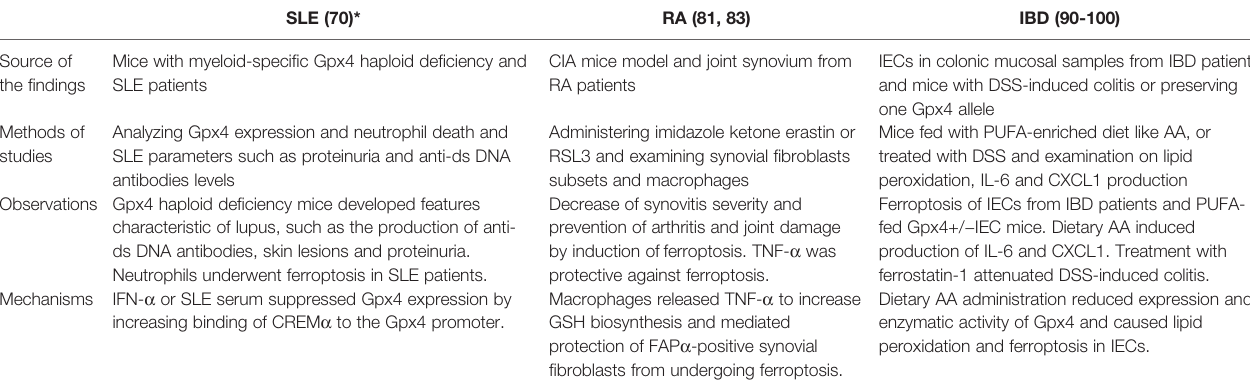
TABLE 2 | Summary of study fi ndings of ferroptosis in autoimmune diseases.